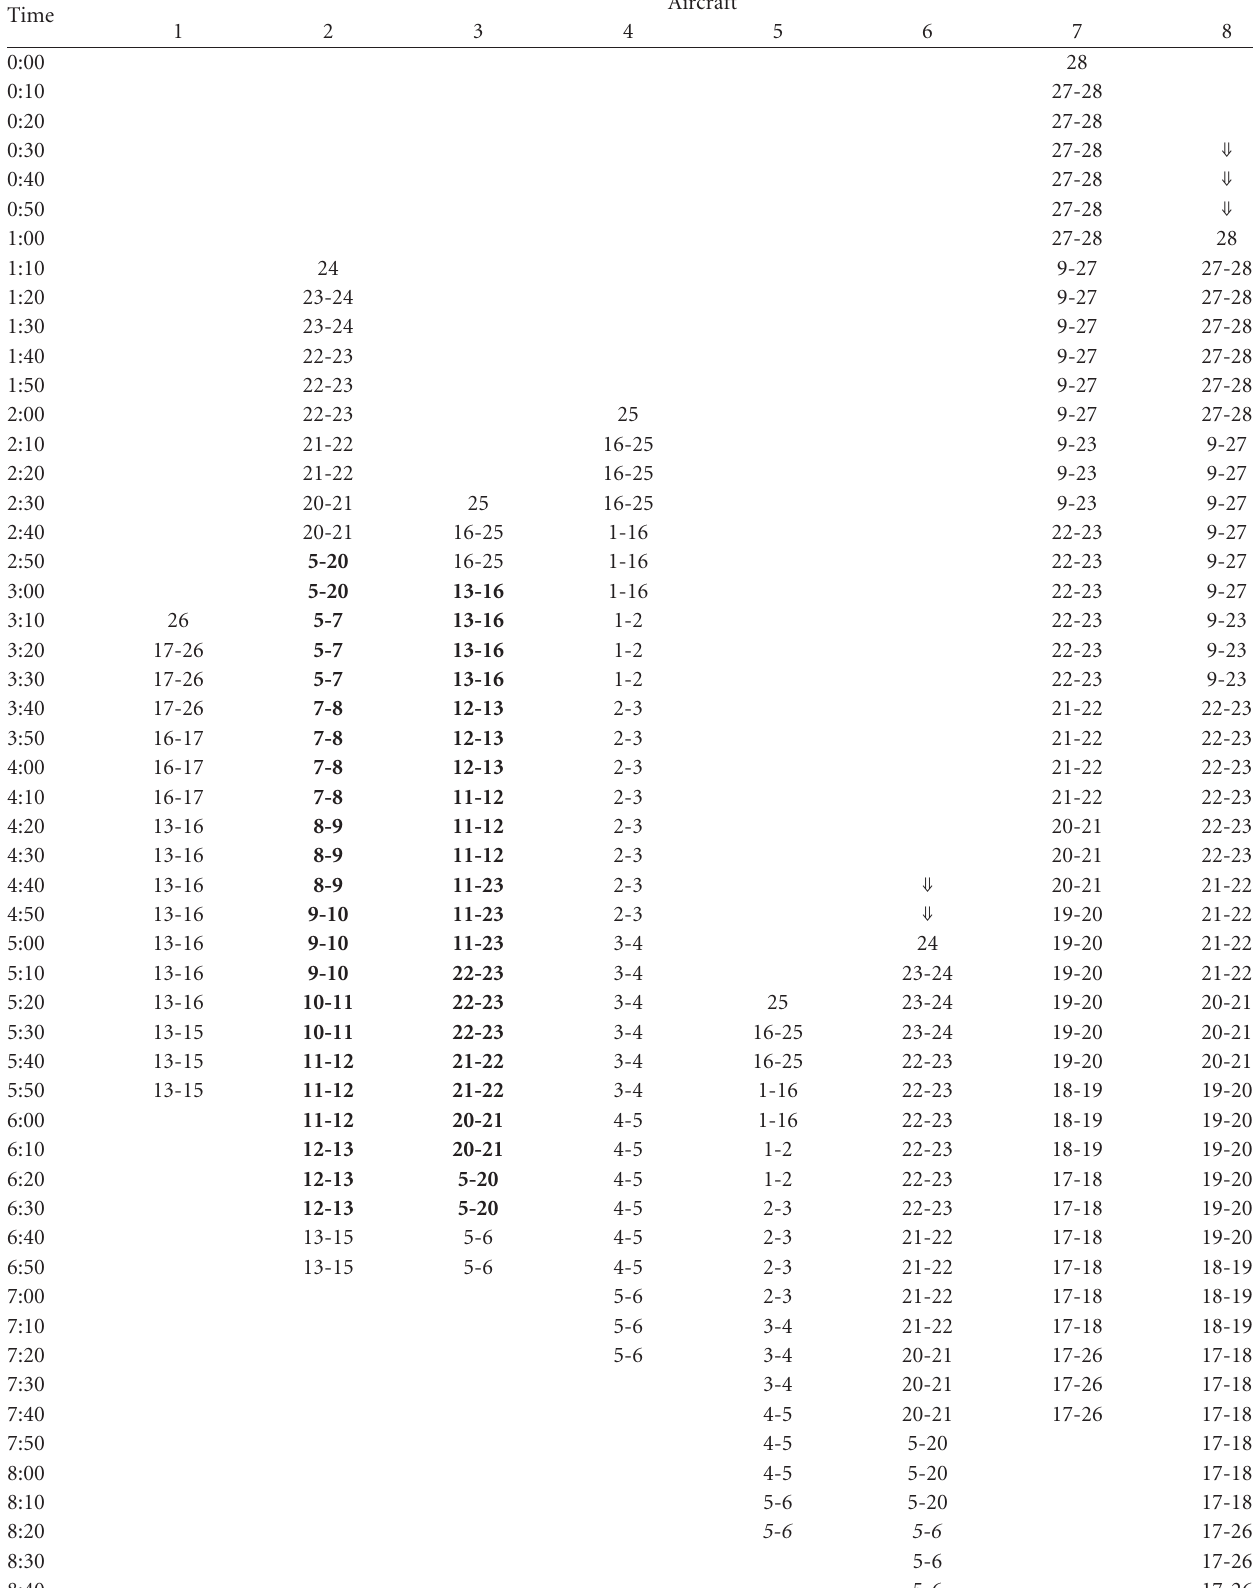
Table 4: First planning update (conflict after